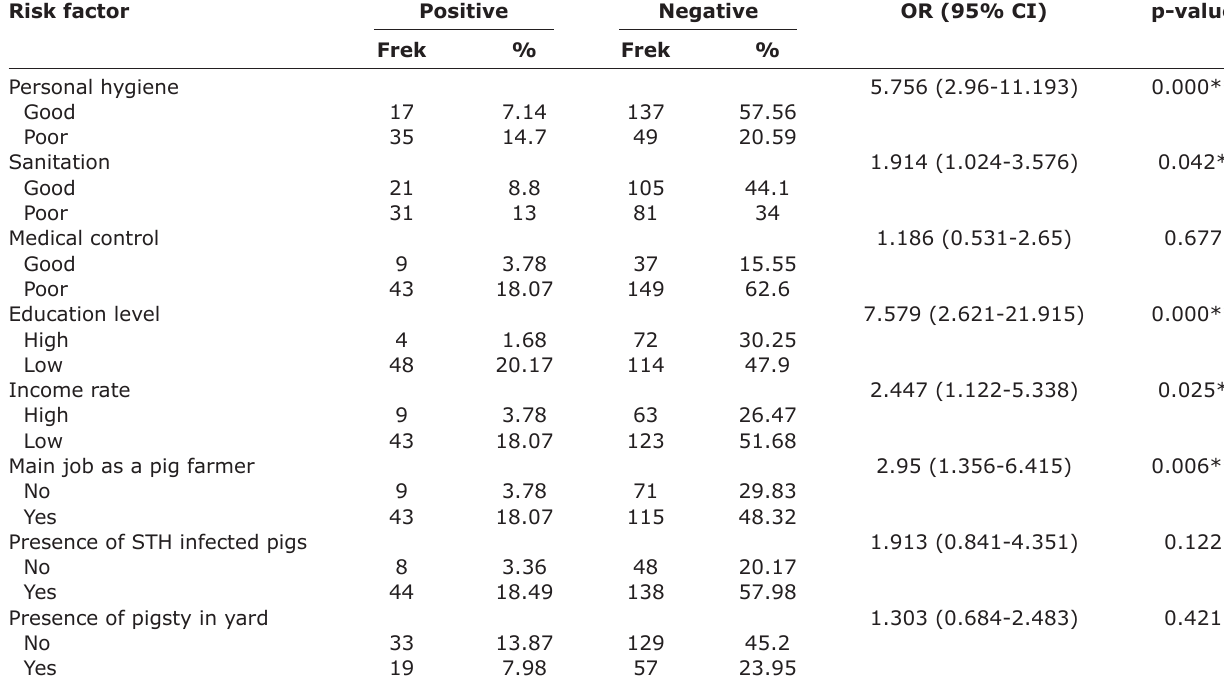
Table-3: Risk factor of STH infection in traditional pig farmers in Bali. Risk factor